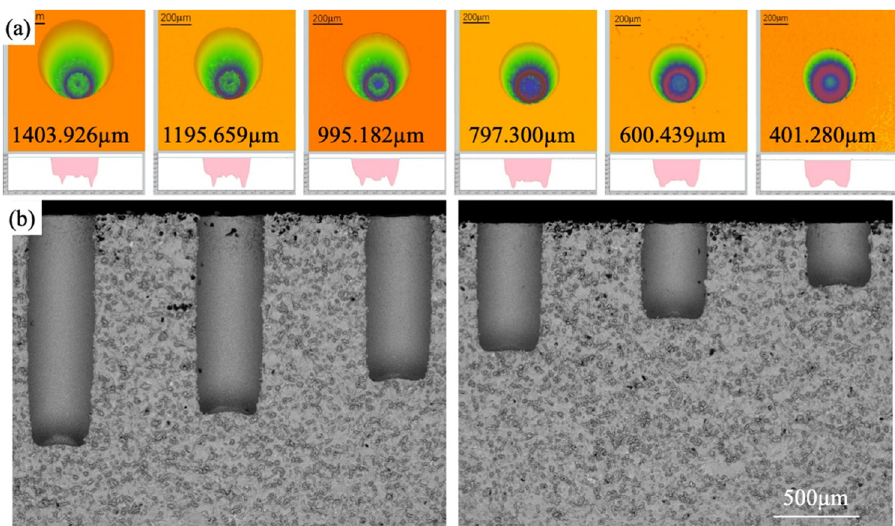
Figure 7: Blind holes processed by tungsten steel electrode: ( a ) the 3D morphology; ( b ) the SEM image ( frequency = 120 kHz, pulse width = 3 µs, current = 2.5, voltage = 90 V, gain coe ffi cient = 15 )